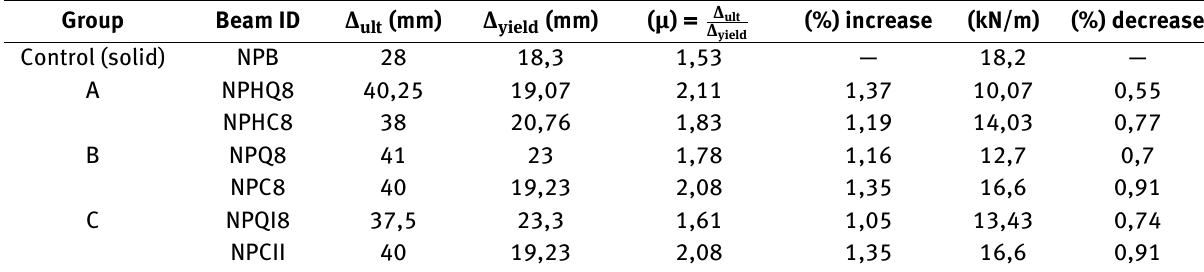
Table 4: Ductility and initial stiffness Group Beam ID ∆ ult (mm) Control